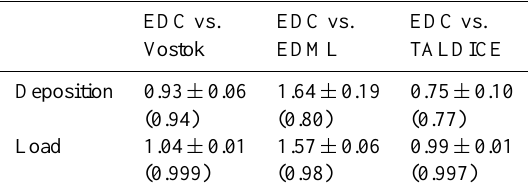
Table 3. Slopes of the linear regressions calculated for the 10yr model runs as shown in Fig. 7. The first line indicates the slopes of the dust deposition (dep.) (Fig. 7d), the second line those of the atmospheric dust load (Fig. 7c). The slopes of the regressions are indicated including the standard deviation, the respective r 2 values are indicated in